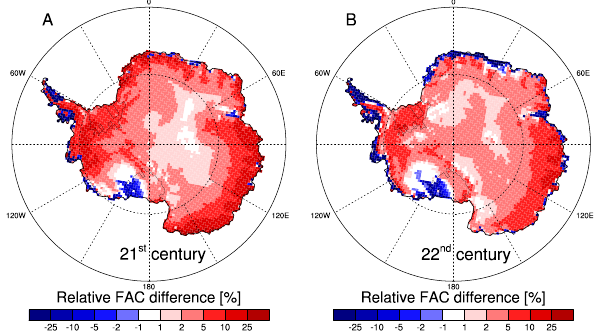
Figure 9. Relative firn air content (FAC) difference over the 21st (a) and 22nd (b) century. The relative differences are calculated as the difference between the 20yr averages of 1980–1999 and 2080– 2099, and 2080–2099, and 2180–2199,